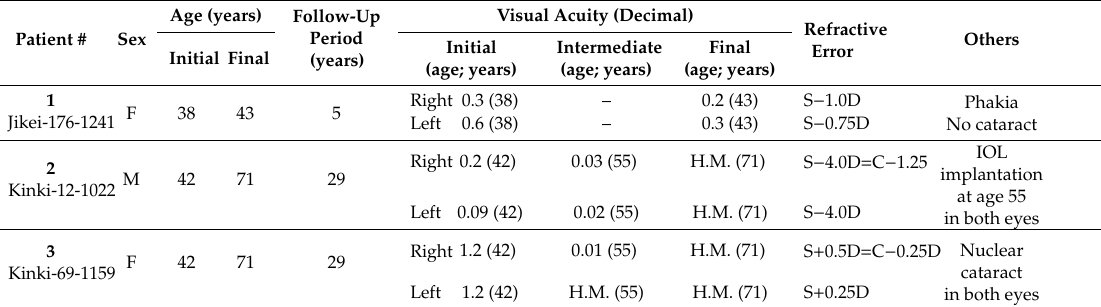
Table 1. Visual acuities and clinical courses of the